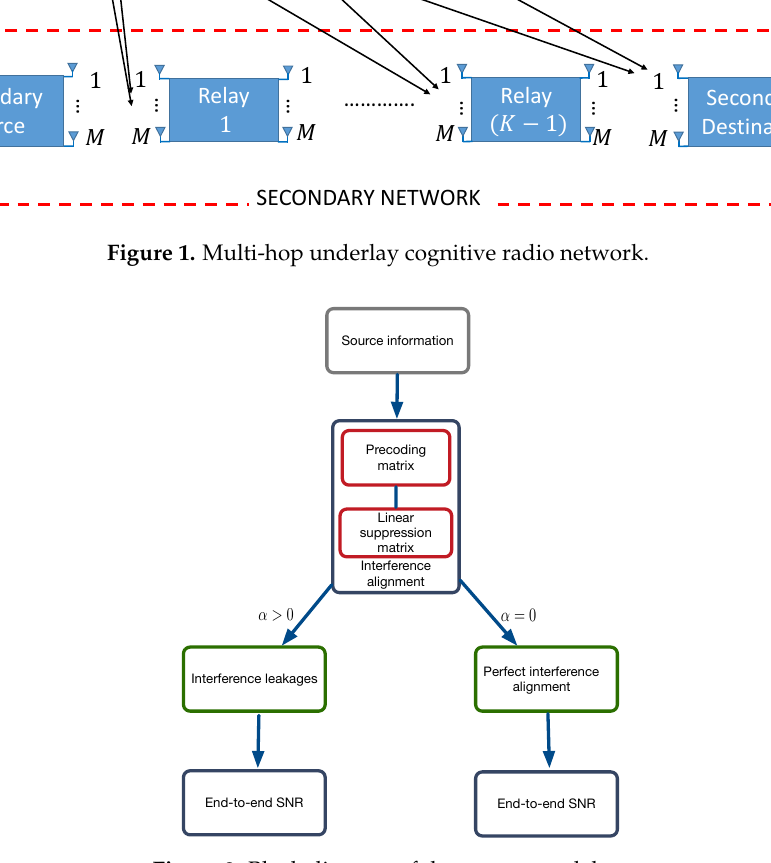
Figure 2. Block diagram of the system